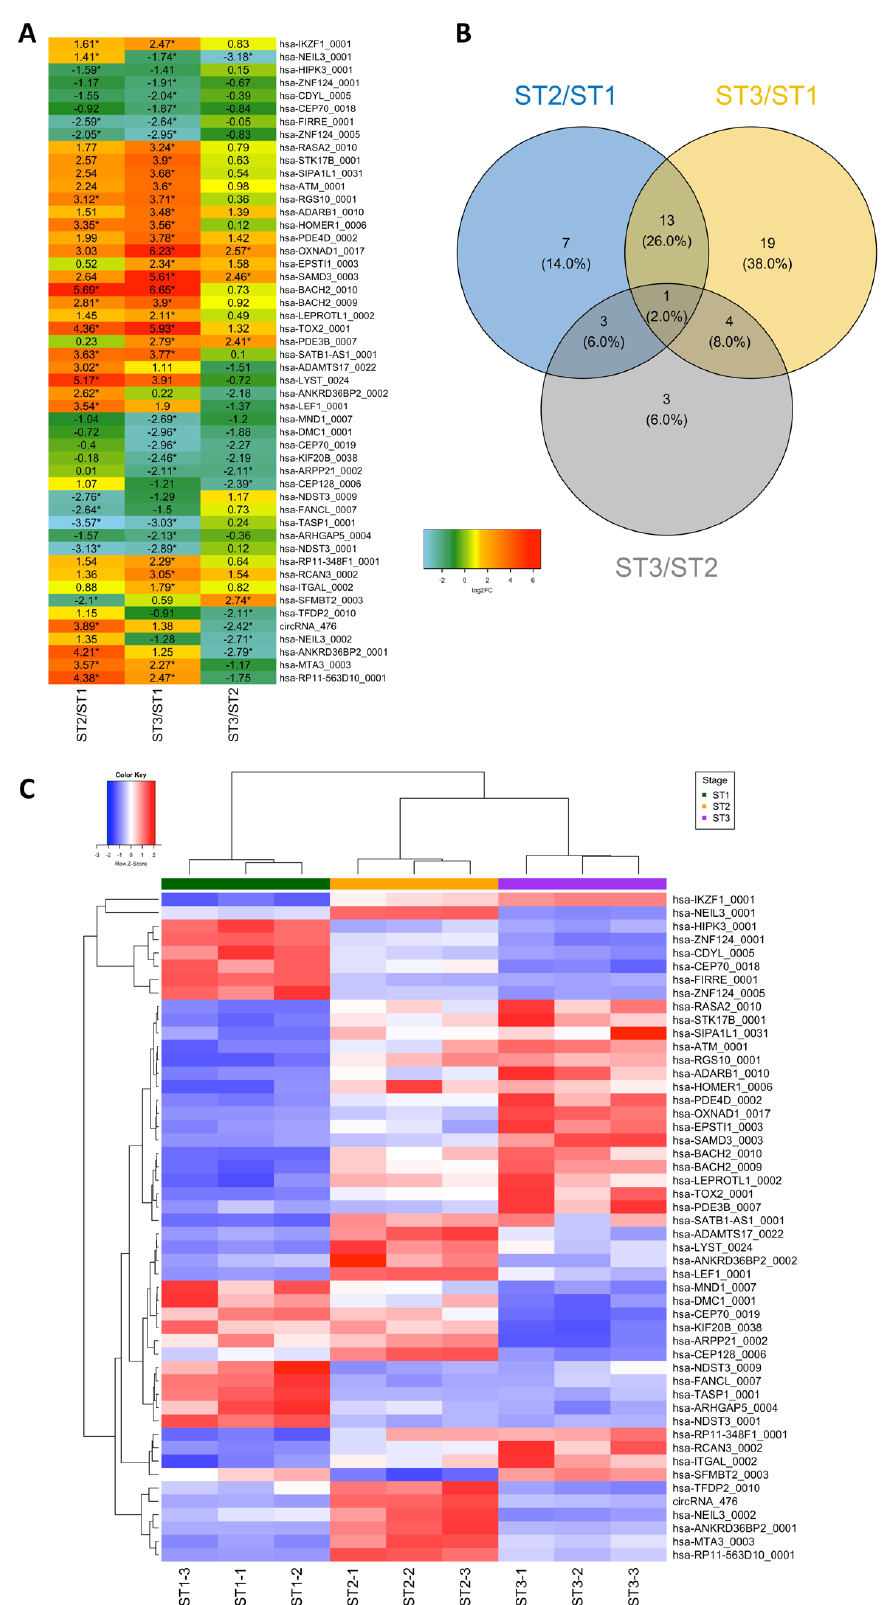
Figure 2. Pairwise comparison analysis and differential expression of circRNAs. ( A ) Heatmap representation depicting changes in the expression of the 50 circRNAs differentially expressed in at least one pairwise comparison. The numbers in each box represent the fold changes (log2FC)